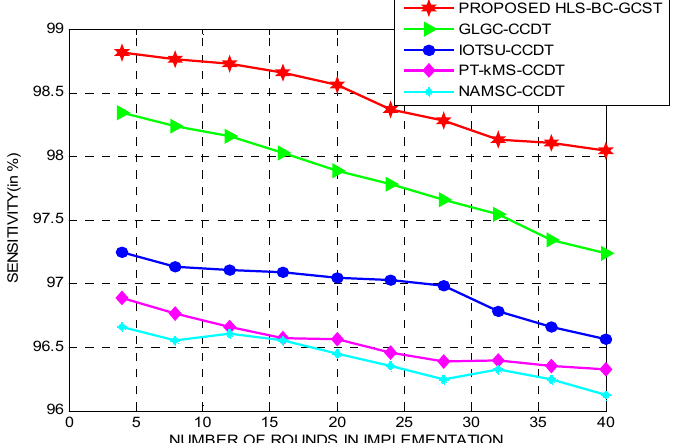
Figure 5. Comparative performance of the proposed HLC-BC-GCST scheme (using sensitivity).